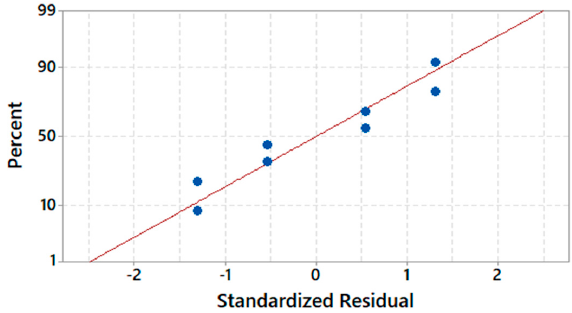
Figure 3. Normal probability plot of residuals for Y 1 .